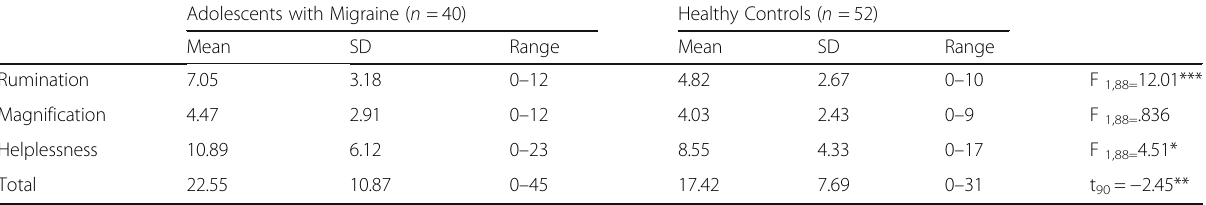
Table 2 Comparing PCS- C scores between adolescents with Migraine and healthy controls